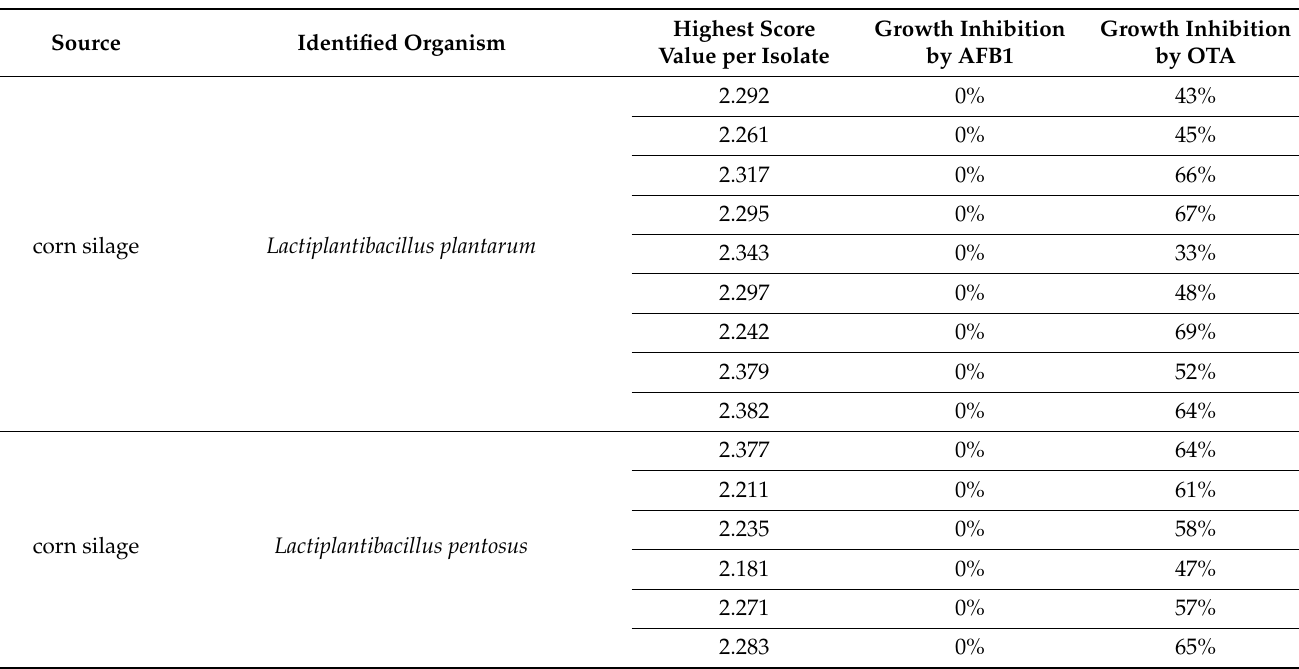
Table 3. Identification results of bacterial isolates from fermented forages and their aflatoxin B1 (AFB1) and ochratoxin (OTA) resistance. All identifications of the isolates based on the protein profile of the bacteria were done in two repetitions with the MALDI-TOF MS technique. Identification with a score value below 1.950 was defined as an uncertain identification, and the analysis was